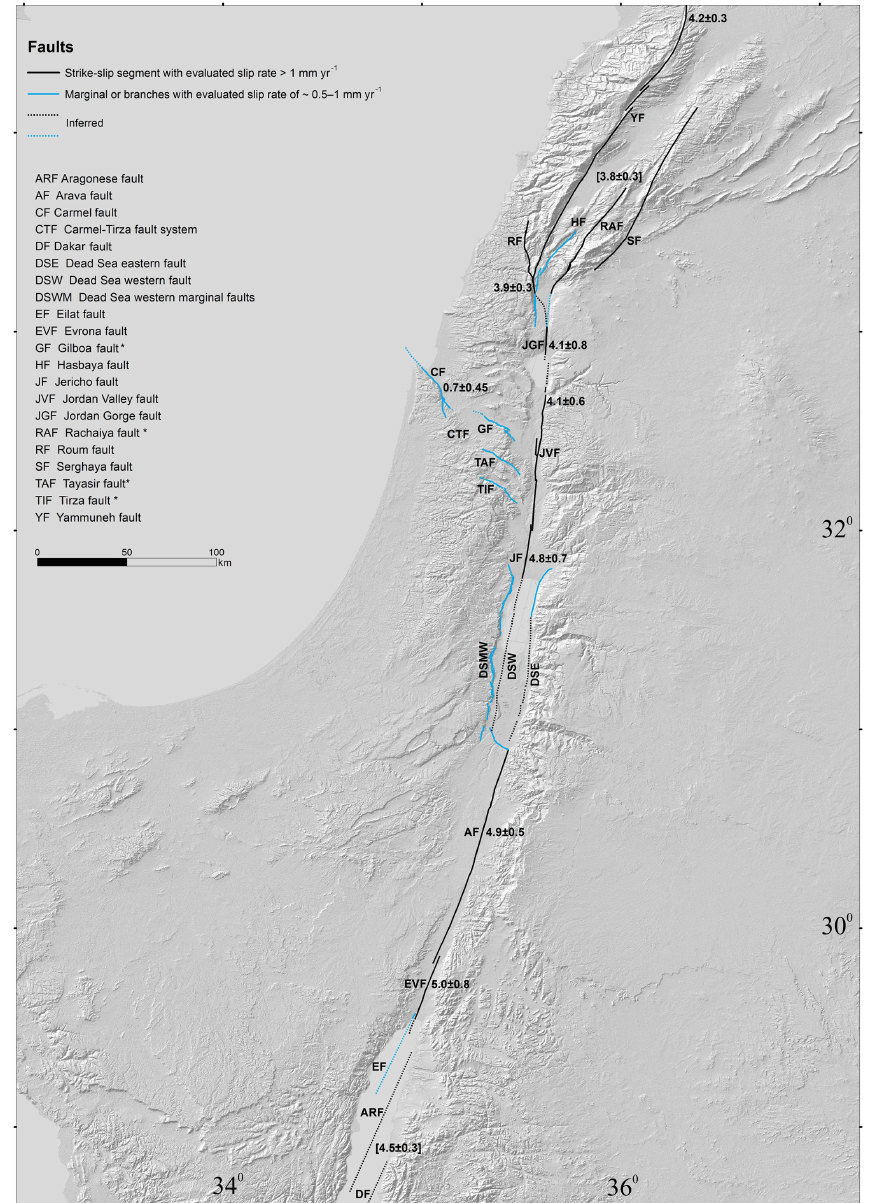
Figure 5. The main seismic sources in Israel and adjacent areas. Colours indicate the two categories of faults according to the criteria. Inferred subsurface faults are marked by dashed lines. Abbreviations are for the DST main strike-slip segments, its main branches and marginal faults. Numbers indicate geodetic slip rates (mmyr − 1 ) for strike-slip components according to recent studies (for longer-term slip rates, see Tables 1 and 2; Fig. A2). Brackets indicate slip rates accommodated by an entire fault zone. Asterisks denote segments of unknown slip rates, where the fault splits into a few (sub-)parallel